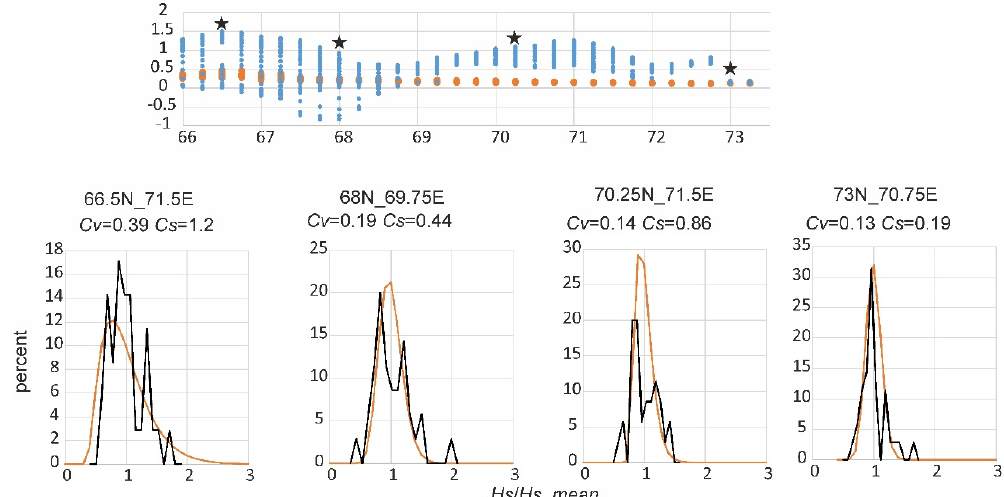
Figure 30. Probability density functions (PDF) for typical combinations of C s and C v of normalized annual maximum H s : black line–PDF on measured data; red–PDF calculated with Equation (21). The upper figure shows the position ( stars ) of these combinations of C s ( blue dots ) and C v ( red dots ) along the south-north direction (from 66 to 73.5 ◦ N). The scatter shows change of the statistics in west-east direction.